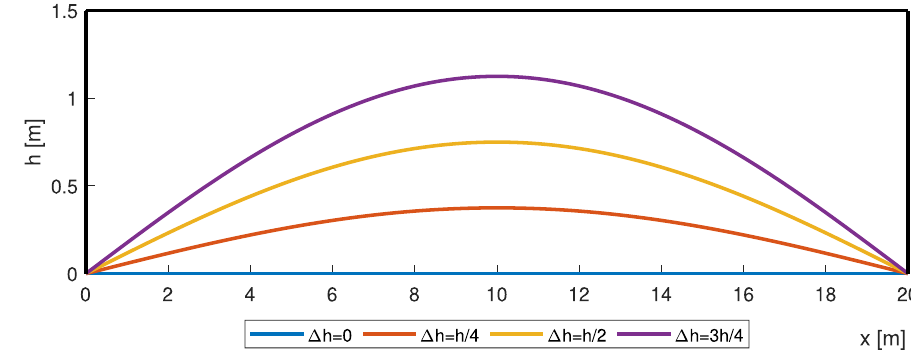
Fig. 3 Illustration of the ideal geometry of a non-prismatic beam with a trigonometric emptying function with one lobe. This ideal model, is in reality calculated with a dog- bone beam model as previ- ously